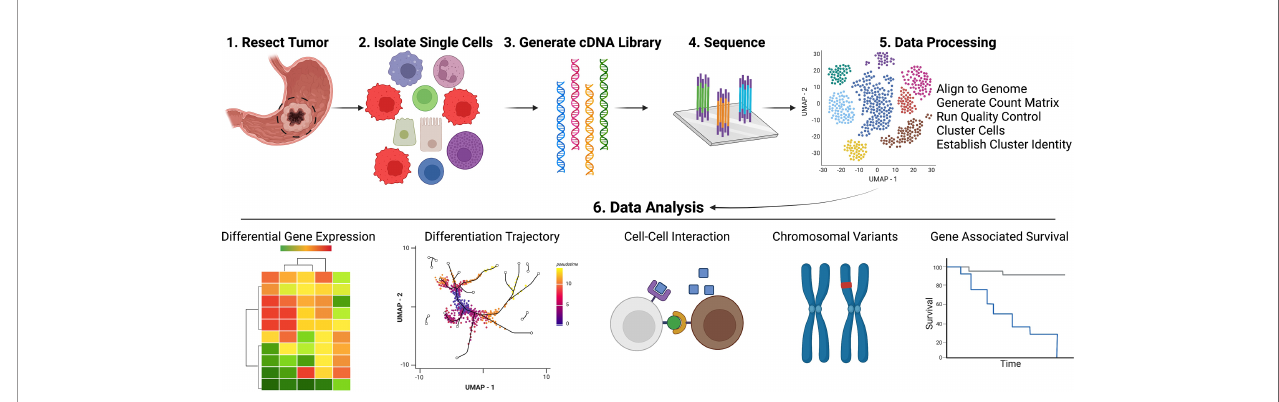
FIGURE 2 | Pipeline for Acquisition and Analysis of Single Cell Data. Created with